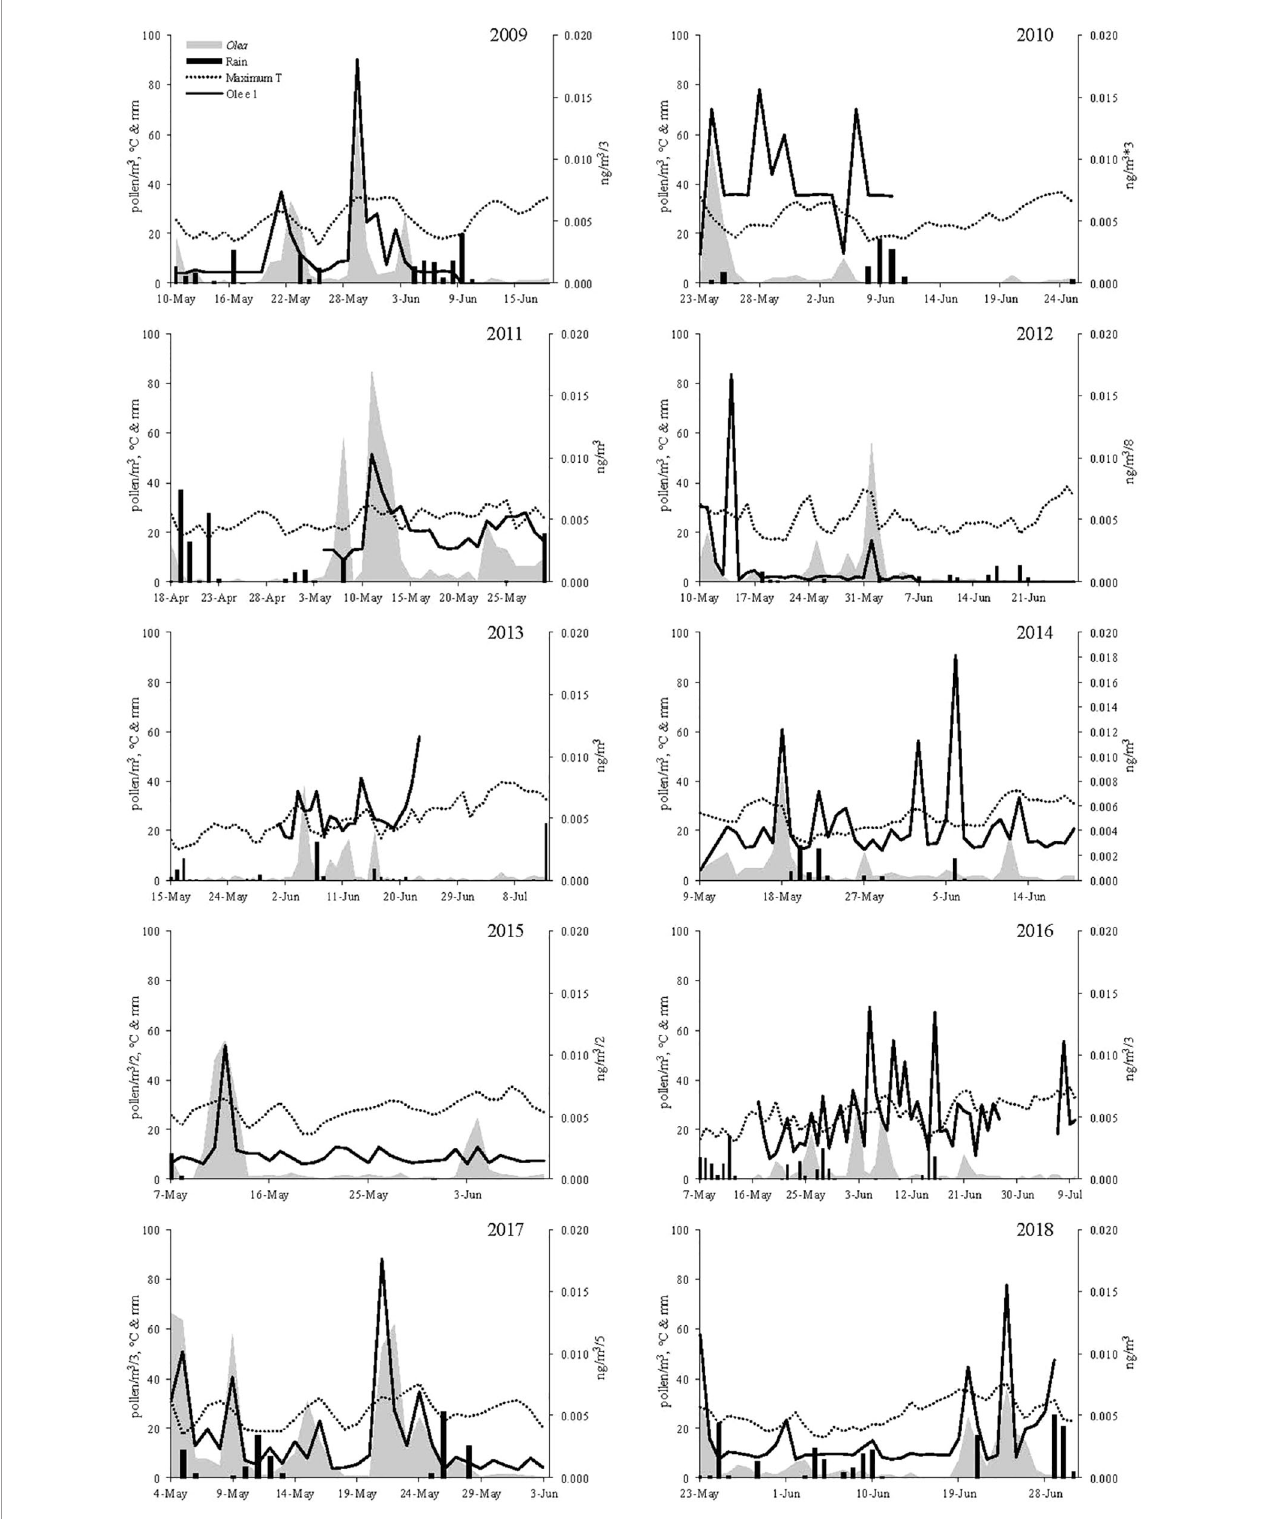
FIGURE 1 | Pollen grains (grey area), Allergen concentration (black line), Maximum Temperature (black points) and Rainfall (black bars) during the study